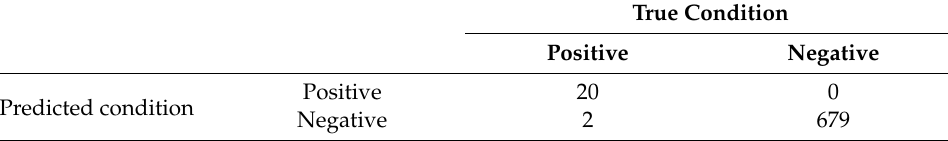
Table 2. Confusion